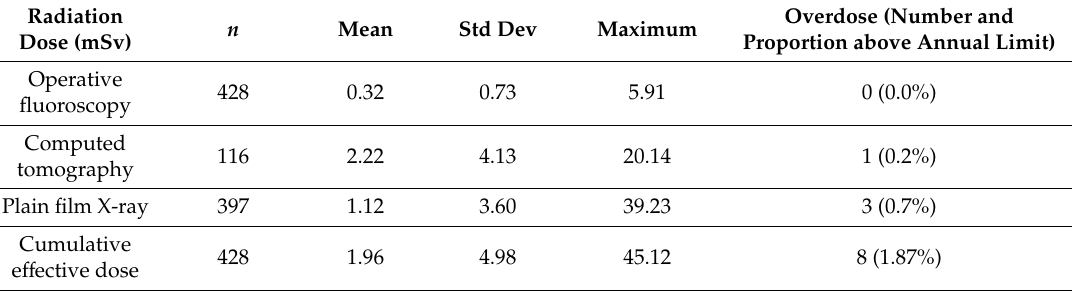
Table 2. Total dose per patient by procedure.